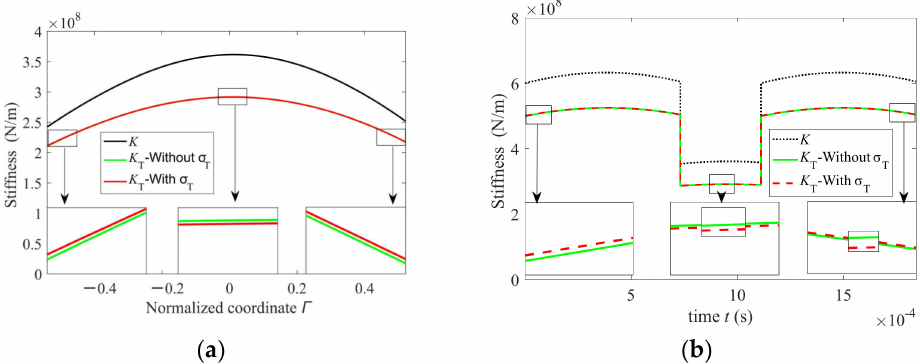
Figure 7. Gear thermal stiffness: ( a ) thermal mesh stiffness of a single tooth pair; ( b ) time-varying thermal mesh